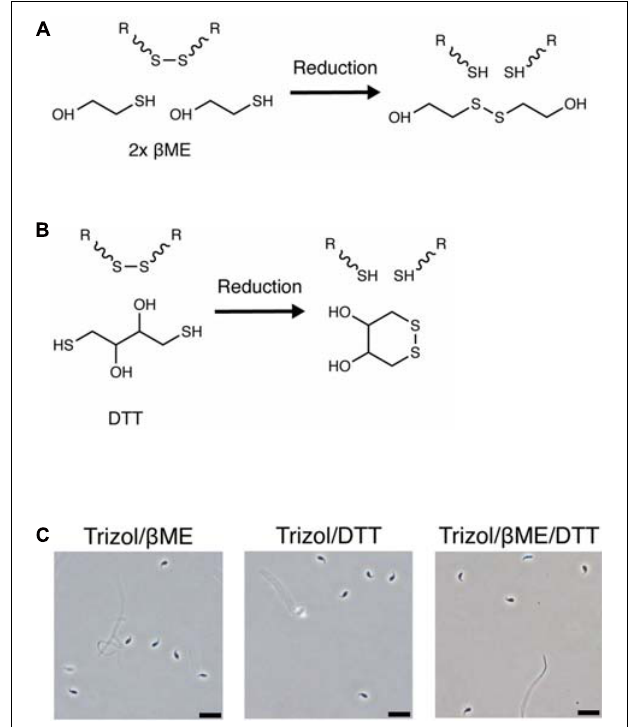
FIGURE 2 | Sperm is not lysed in Trizol supplemented with β ME or DTT. (A,B) Chemical reduction of a protein disulfide bond by (A) β ME or (B) DTT. (C) Mouse sperm is not lysed in Trizol supplemented with 100 mM β ME, 100 mM DTT or a combination of both. Scale bars = 20 µ m.